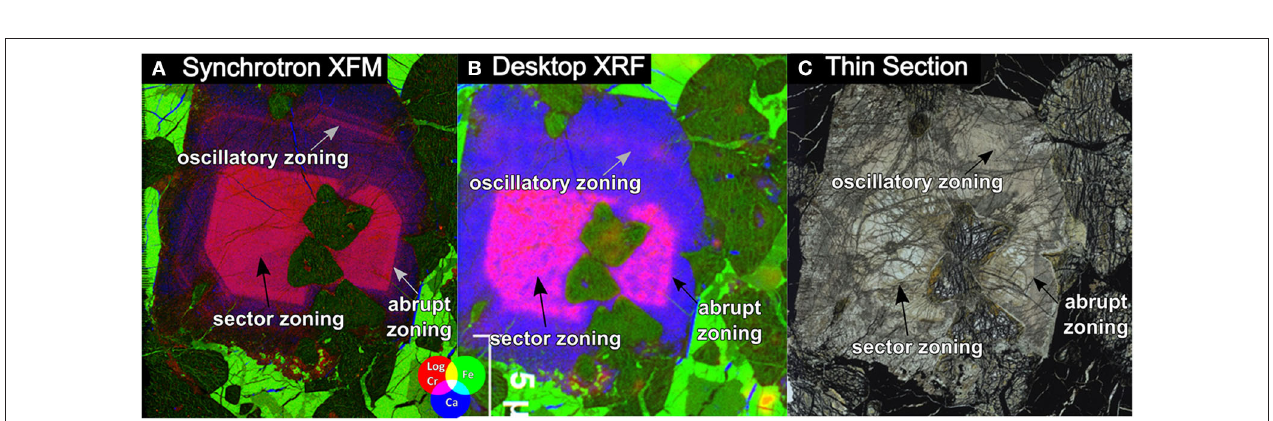
FIGURE 11 | The sector zone enrichment factor for Cr (high concentration sector over low concentration sector) for orthopyroxene (opx) in samples taken from the Australian Synchrotron µ XRF maps. Average for each category is Barren = 1.4, weakly mineralized = 1.5, ore grade = 1.6.